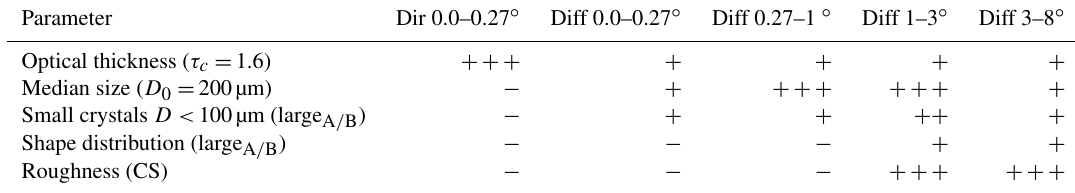
Table 3. A semi-quantitative summary on the strength of the impacts of microphysical parameters to the direct radiance and four differ- ent angular regions of circumsolar radiance. Impacts due to the ice cloud optical thickness are addressed in the first row and those due to size, shape, and roughness of ice crystals in the following rows. In parentheses is the parameter value against which the relative differ- ences are calculated. The maximum relative strength of the impact is given with symbols: − (impact < 50%), + (50% < impact < 100%), ++ (100% < impact < 200%), and +++ (200% < impact). It is based on the conducted sensitivity tests (see Figs. 7–11).